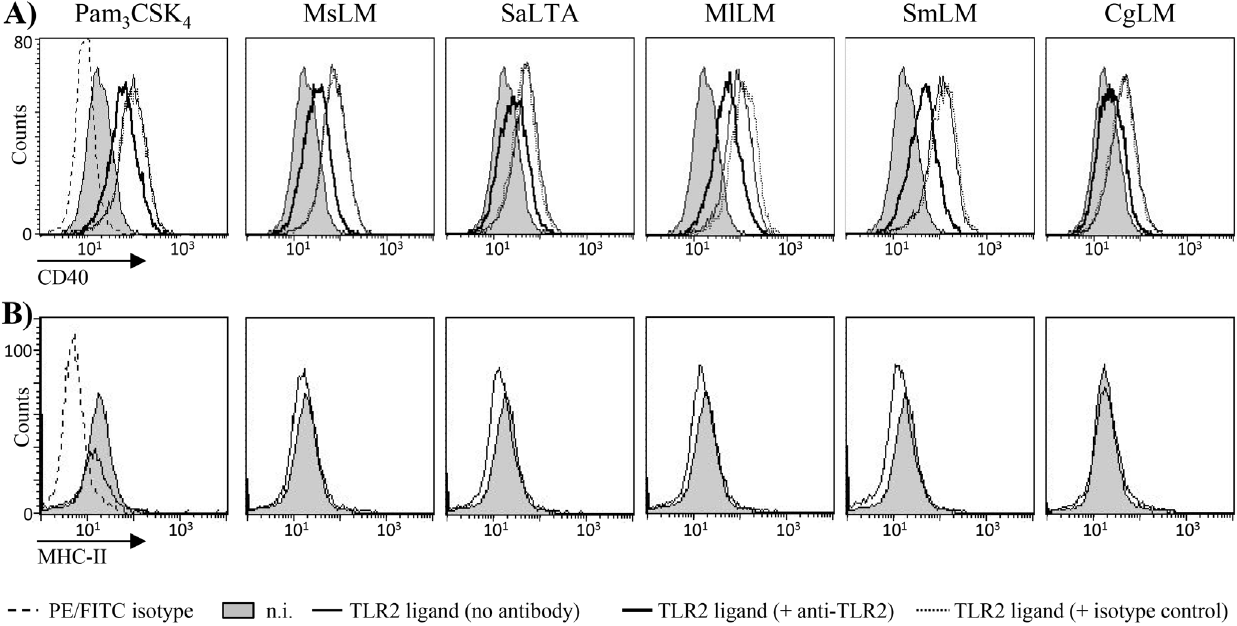
Figure 4. DAG-based lipoglycans stimulate TLR2-dependant cell surface co-stimulatory molecule CD40 but not MHCII expression by human THP-1 monocyte/macrophage cell line. THP-1 cells were pre-incubated or not for 30 min at 37 u C with 10 m g/ml of anti-TLR2 or IgG1 isotype control antibodies and stimulated overnight with the different TLR2 ligands at a concentration of 1 m g/ml. CD40 (A) and MHC-II (B) expression was monitored by flow cytometry. One representative experiment (from three repeats) is shown. n.i., not